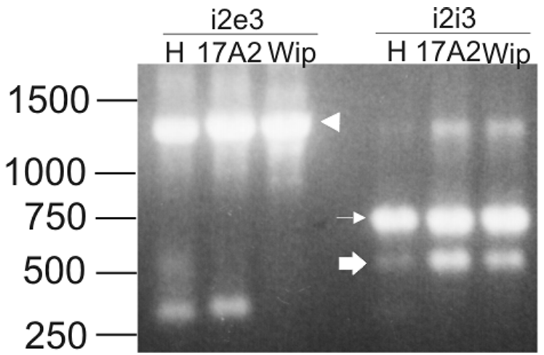
Fig. 2 – Agarose gel electrophoresis with RT-PCR amplification products from embryos of D. melanogaster (H) and D. willistoni (17A2 and Wip). The first step of cDNA amplification was carried out with meli1+ and mele3- primers. (i2e3) PCR reamplification with meli2+ and mele3- primers. (i2i3) PCR reamplification with meli2+ and meli3- primers. The narrow arrow indicates the transposase frag- ment; the arrowhead indicates the 66-kDa transposase repressor frag- ment; the thick arrow indicates a fragment with truncated exon 2. A 1-kb DNA ladder is depicted on the left.